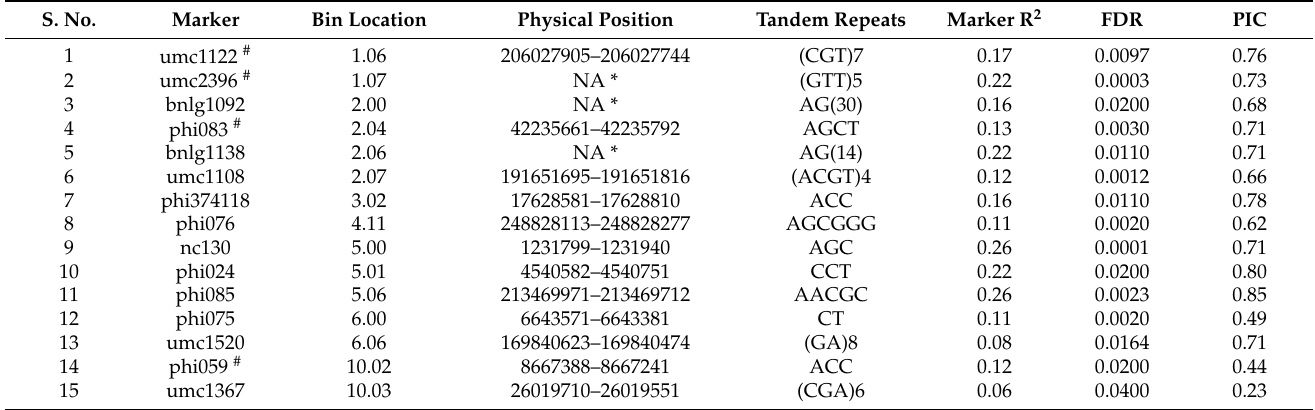
Table 3. Simple sequence repeats markers found significantly ( p < 0.001) associated with turcicum leaf blight resistance in marker-trait association analysis done using general linear model.